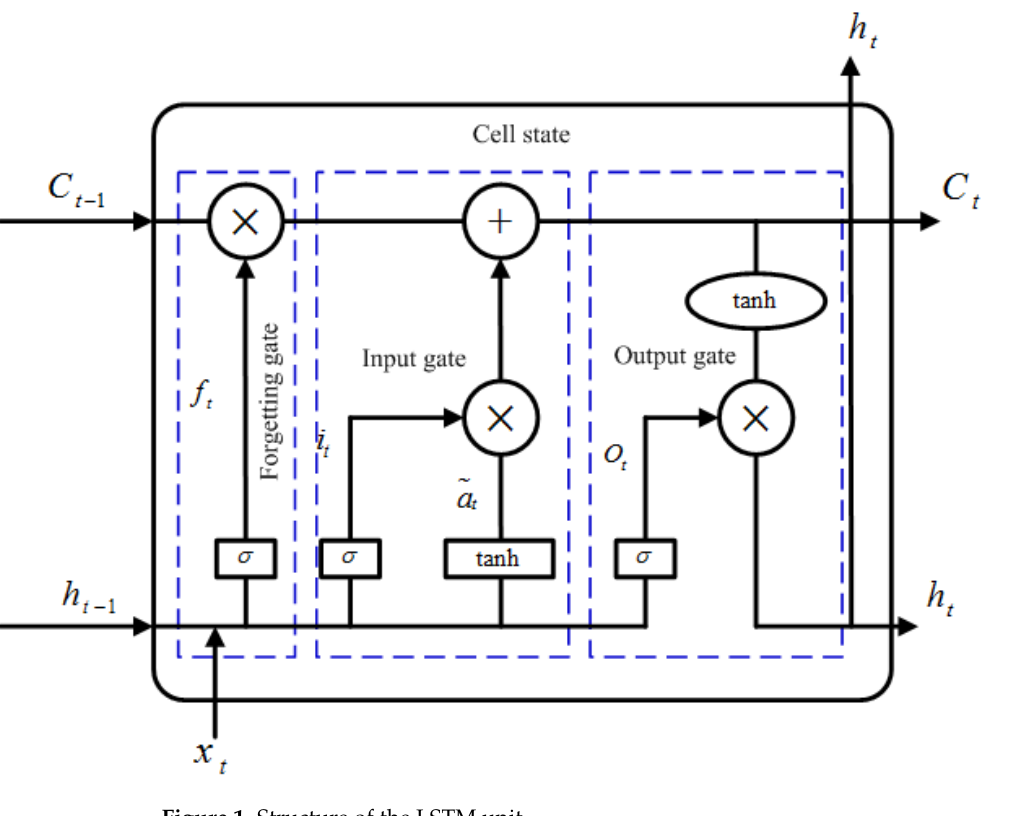
Figure 1. Structure of the LSTM unit.